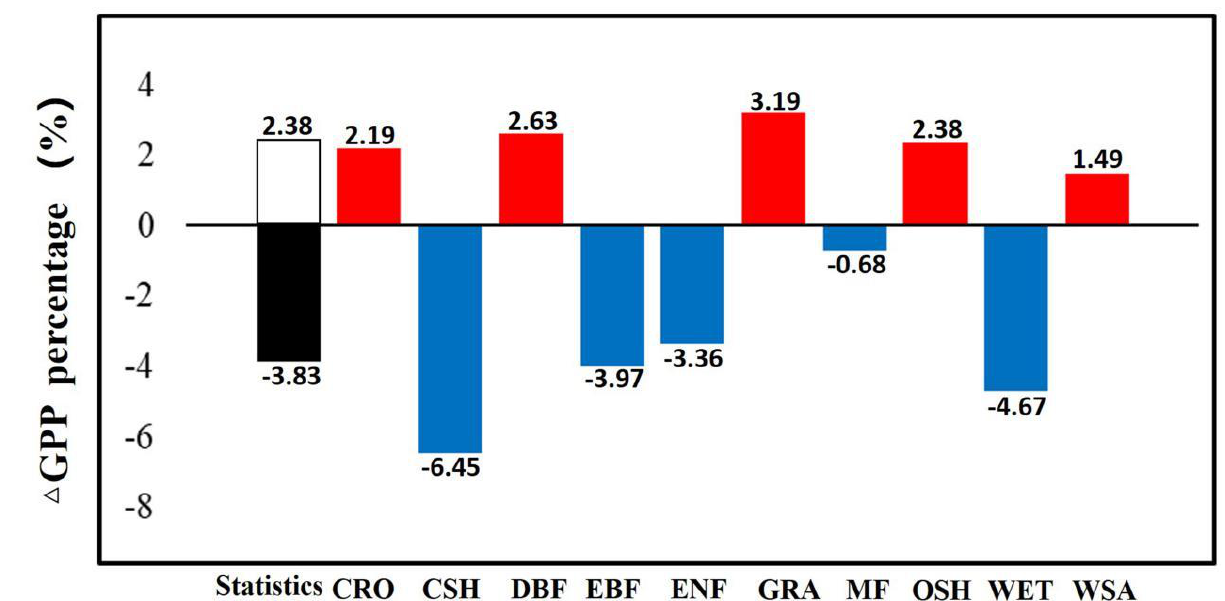
Figure 7. Percentage changes in GPP caused by aerosols globally and in different biomes: Crop (CRO). Closed Shrub (CSH), Deciduous Broadleaf Forest (DBF), Evergreen Broadleaf Forest (EBF), Evergreen Needleleaf Forest (ENF), Grassland (GRA), Mixed Forest (MF), Open Shrub (OSH), Wetlands (WET), Woody Savanna